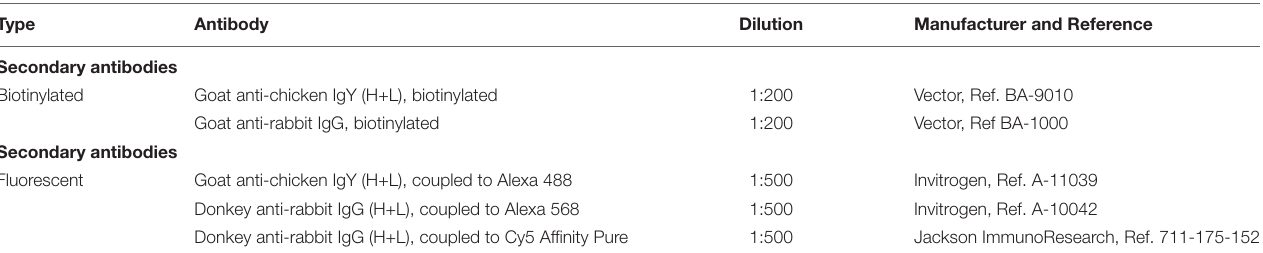
TABLE 2 | Secondary